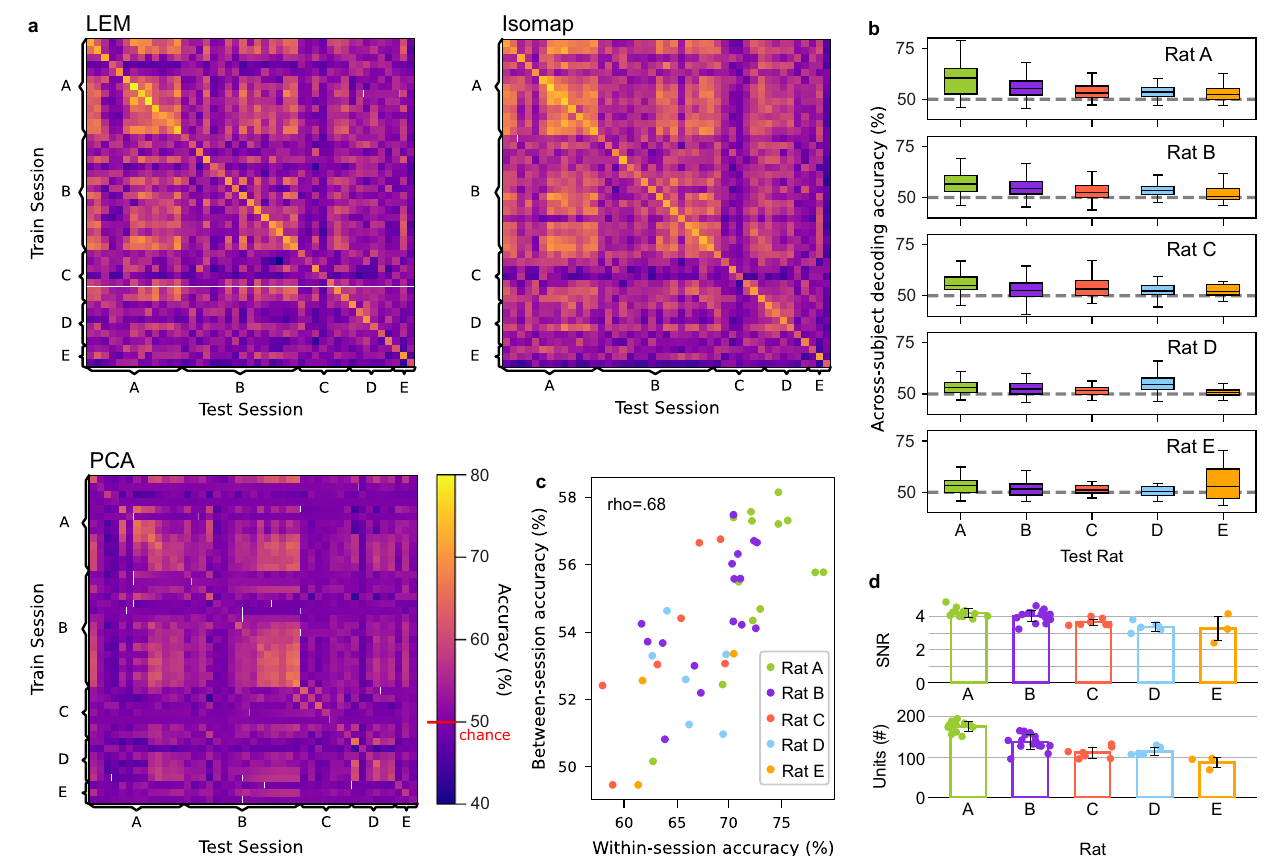
Fig. 5 | Similar structures of population activities allow for cross-subject decoding. Results for a classi fi er trained on two behavioral classes of one rat (chance level 50%, red line) and tested on another rat after using four disjointed behavioral classes to align the neural manifolds. All values in the orange-to-yellow spectrum indicate accuracies above the chance level. a Complete mean per-class accuracies across training and test sessions when aligning on four classes and testing on two in the LEM/Isomap/PCA spaces. On the diagonal, training and test datacamefromthesamesession.Off-diagonalentriesrefertotestsondatasetsthat werenotidenticaltothoseofthetrainingsession.Valuesareaveragedover20runs, and there are 15 possible splits of the six behavioral classes into alignment and decodingsets. b Averageofthemeanper-classaccuracieswhentrainingaclassi fi er